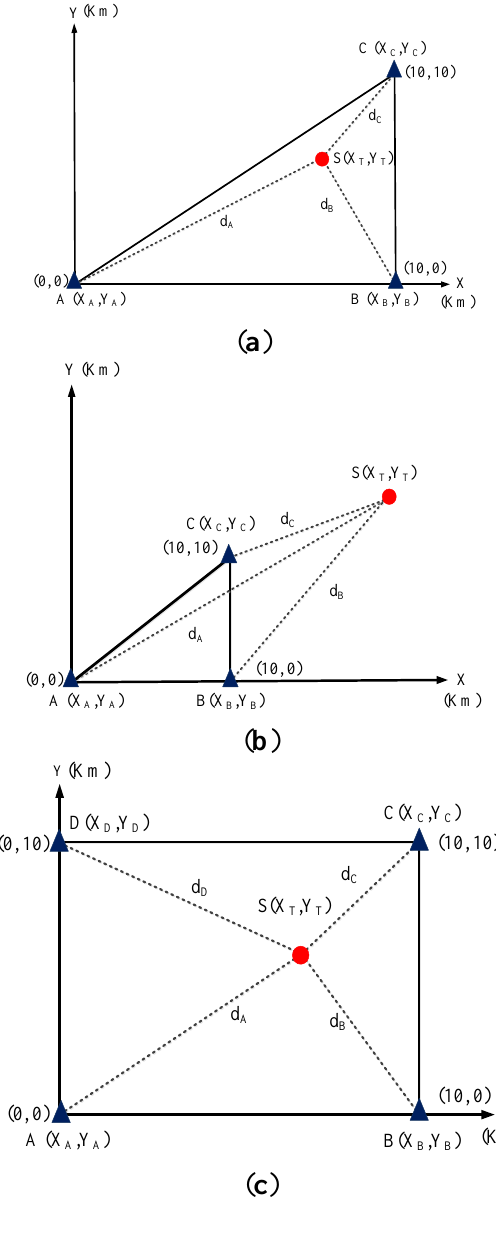
Figure 9. The simulated configuration of various scenarios on ( a ) inside coverage area ( b ) outside coverage area ( c ) spreading (extending) locating networks of TDOA-based locating